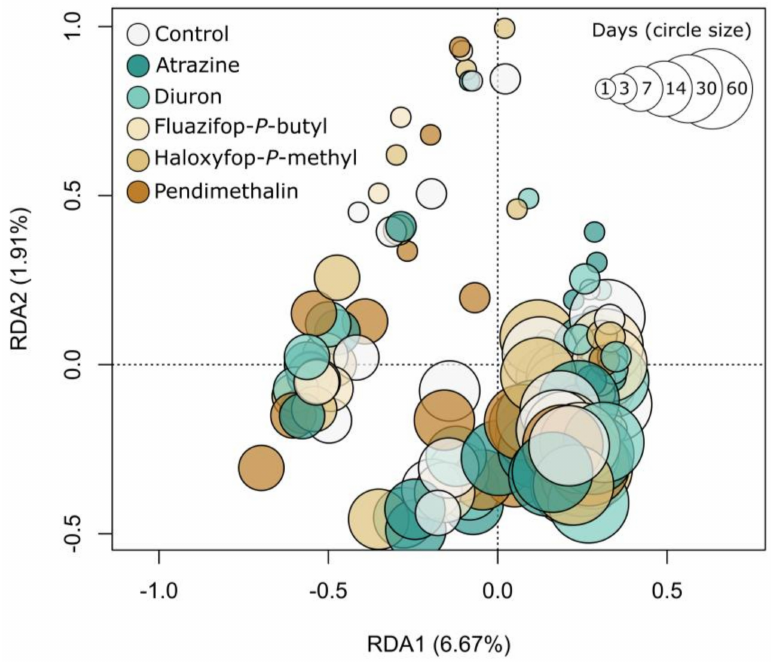
Figure 4. A distance-based redundancy analysis ordination highlighting differences in the com- position (Hellinger-transformed OTU relative abundances) of bacterial and archaeal communities between